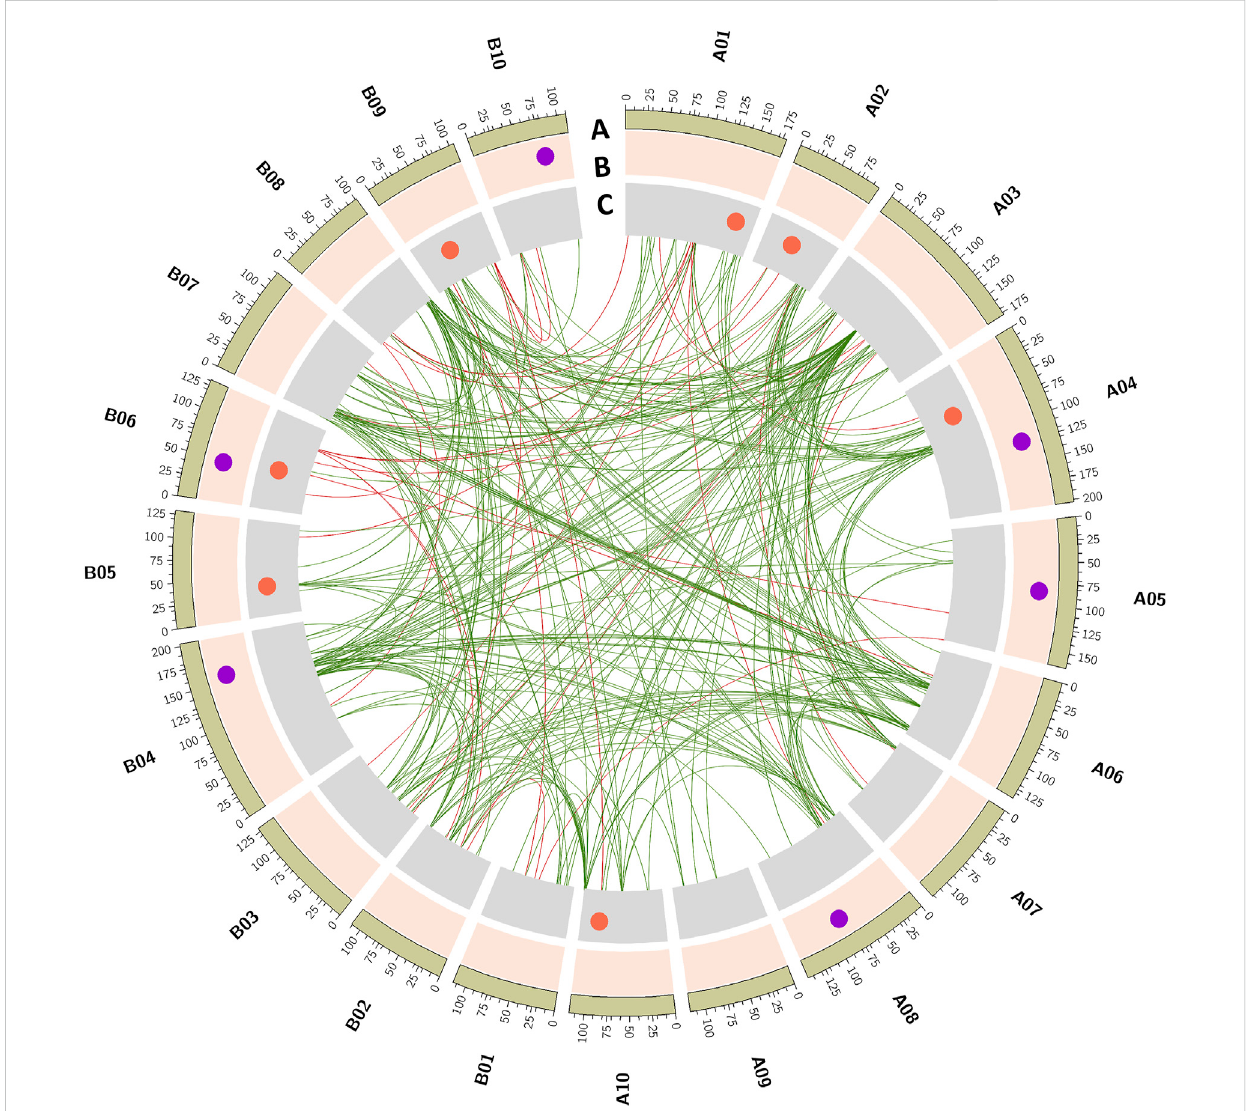
FIGURE 3 Main-effect QTLs identi fi ed for hundred-seed weight (HSW) and shelling percentage (SHP). The tracks outside to inside illustrates, (A) 20 chromosomes of cultivated groundnut labeled as A01 to A10 and B01 to B10, (B) QTLs identi fi ed for shelling percentage (SHP), (C) QTLs identi fi ed for hundredseedweight.Innerlinksrepresentepistatic(Q×Q)interactions.Greencolorlinksrepresenttheepistaticinteractionforshellingpercentage,and red color links are epistatic interactions for seed